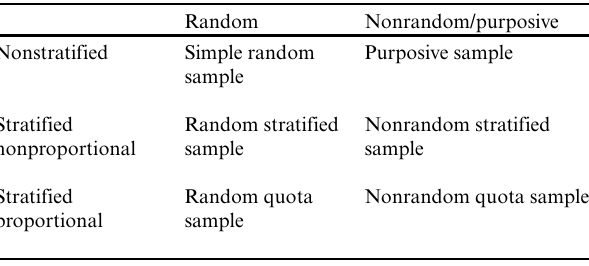
Table 1 . Sampling